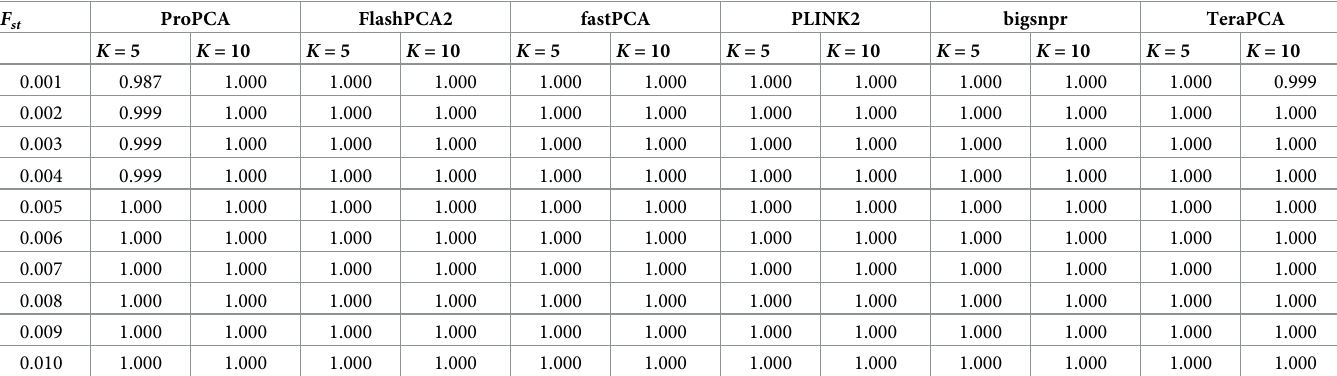
Table 1. ProPCA accurately estimates principal components relative to other methods.